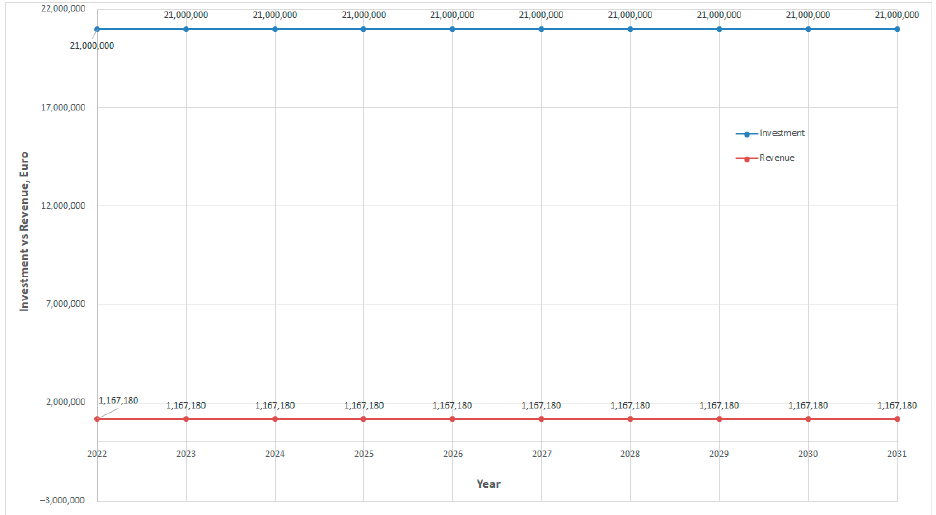
Figure 14. Volume of investment costs and revenues, EUR—scenario 2 (source: authors based on the analysed data).